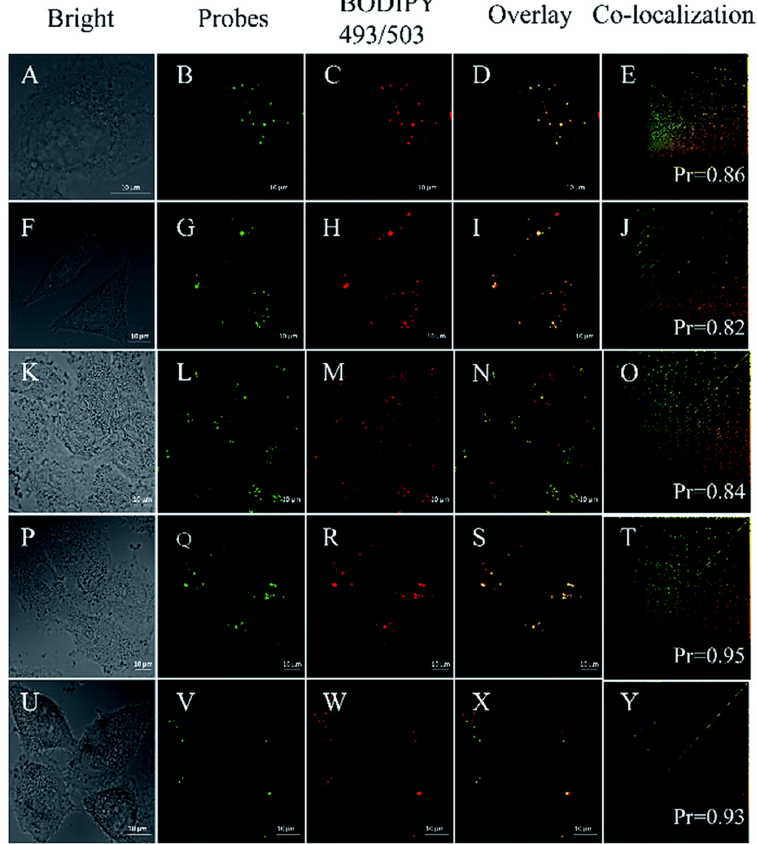
Figure 23. Confocal fluorescence images of HeLa cells stained with BODIPY 493/503 and ( A – E ) 27a ,